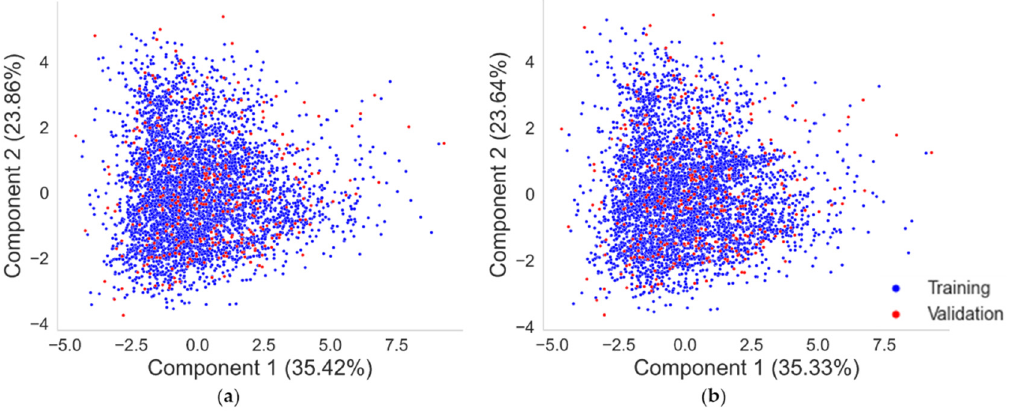
Figure 11. PCA projections of the training set (blue) and external test set (red) for Gram+ ( a ) and Gram − ( b ) categories.